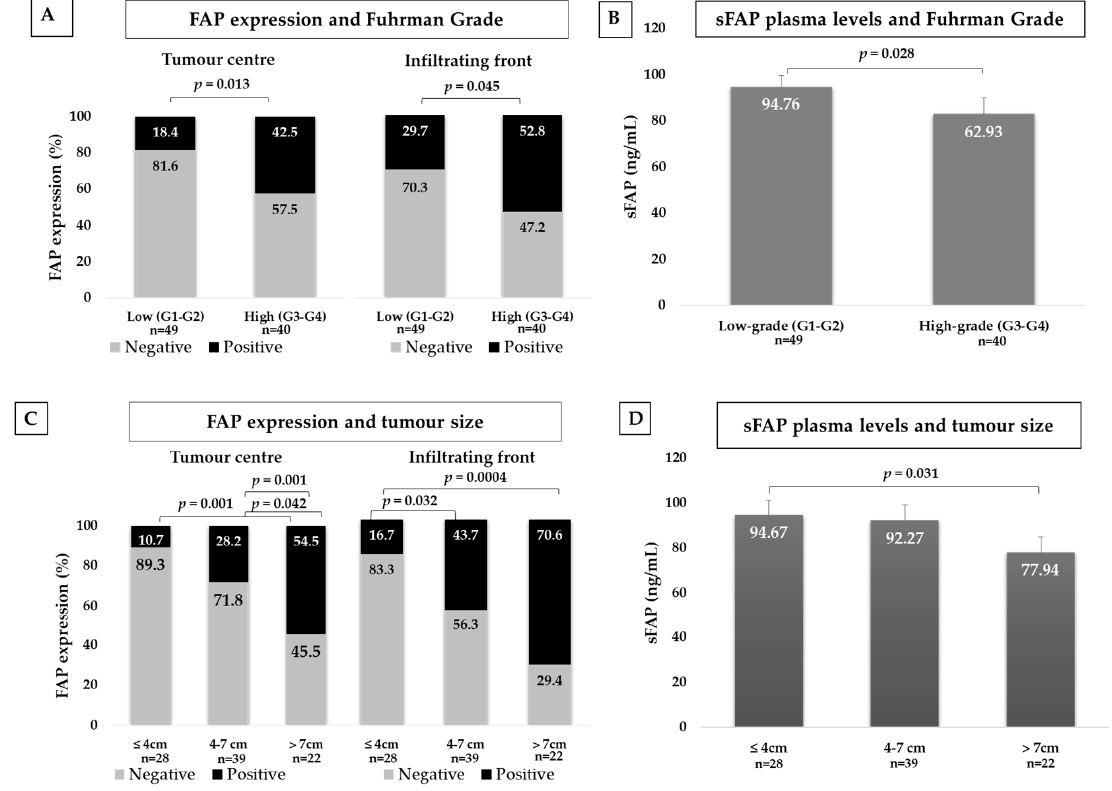
Figure 2. Immunohistochemical FAP staining and plasma levels of soluble FAP (sFAP) according to clear cell renal cell carcinomas (CCRCC) aggressiveness. FAP immunostaining in centre and border of tumours and plasma levels of CCRCC patients depending on histological grade ( A , B ) and tumour diameter ( C , D ). FAP staining intensity was scored as negative or positive (Chi-square test). Results in plasma samples were analysed with Mann–Whitney test.